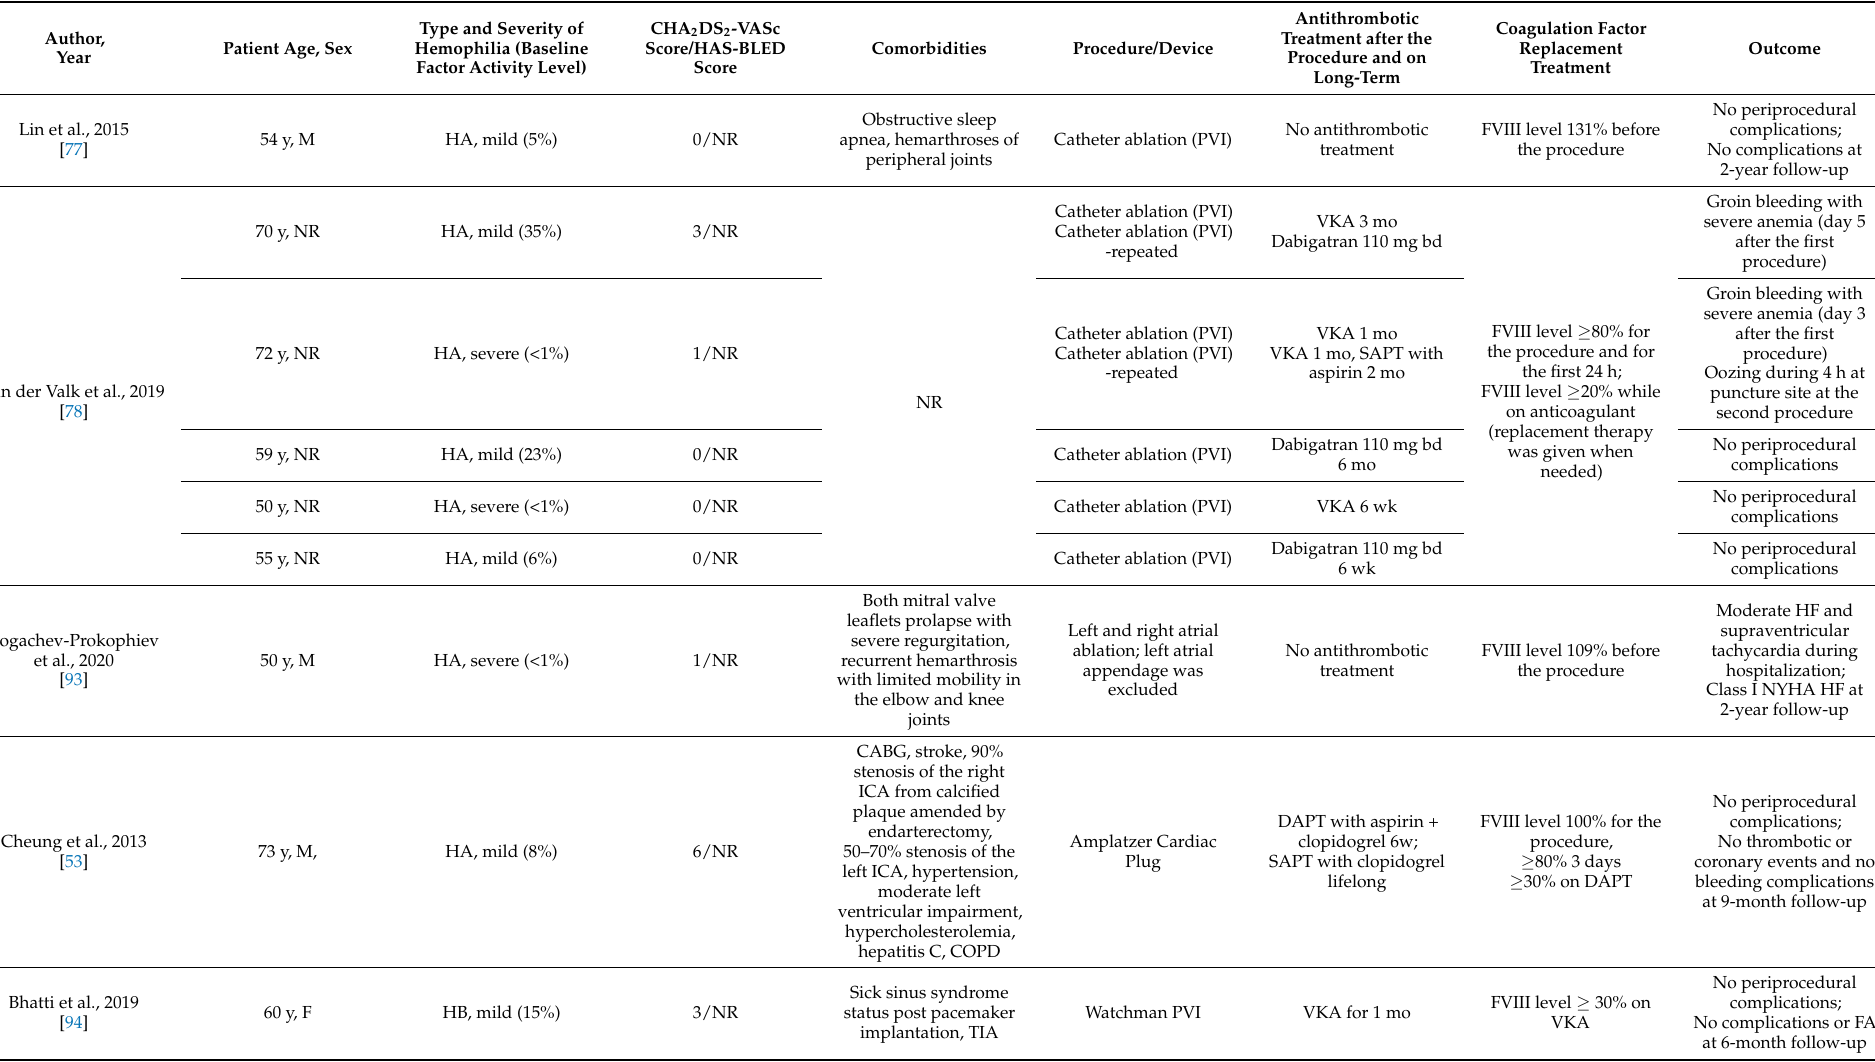
Table 1. Reports on the non-pharmacological treatment of